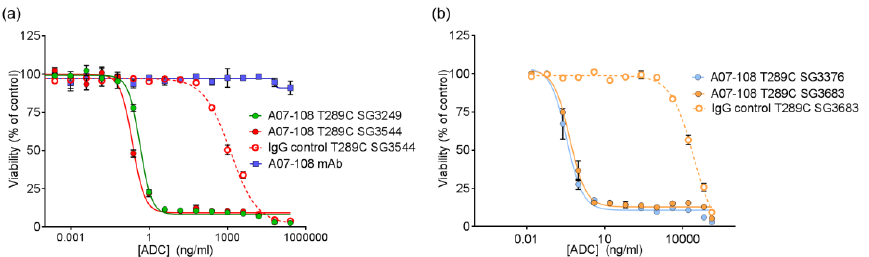
Figure 6. In vitro cytotoxicity of A07-108 antibody-drug conjugates (ADCs) towards cultured MDA-MB-361 cells. ( a ) Activity of ADCs prepared with cleavable pyrrolobenzodiazepine (PBD) drug-linkers; and ( b ) activity of ADCs prepared with non-cleavable PBD drug-linkers. Table 2. Summary ADC activities in vitro.